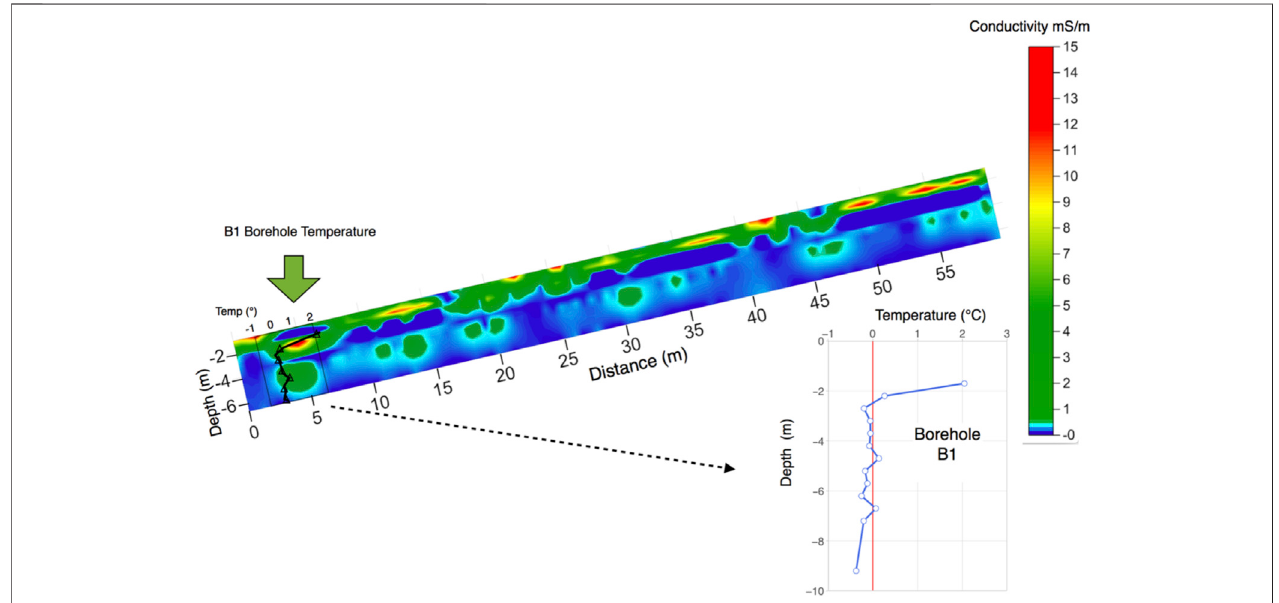
FIGURE 8 | FDEM1 survey data across the Borehole B1 on July 30, 2019. Borehole B1 is shown, in the lower panel the daily mean temperatures collected on the same day.